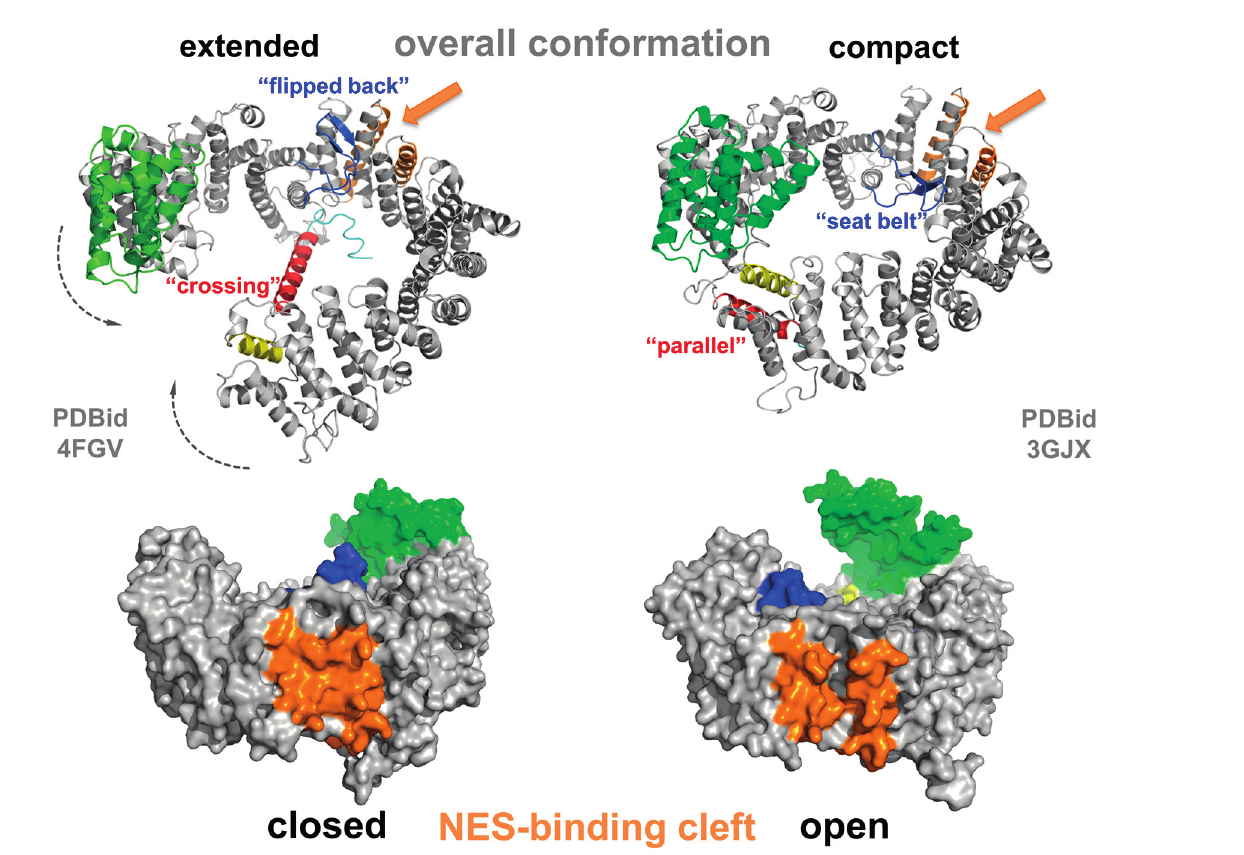
Figure 3. Structural changes of CRM1 between the extended and compact